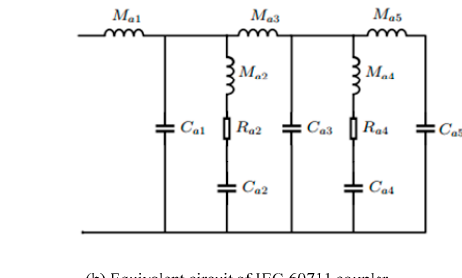
Figure 10. Cross-section view and equivalent circuit of IEC-60711 coupler. Table 1. Parameters of IEC-60711 coupler.